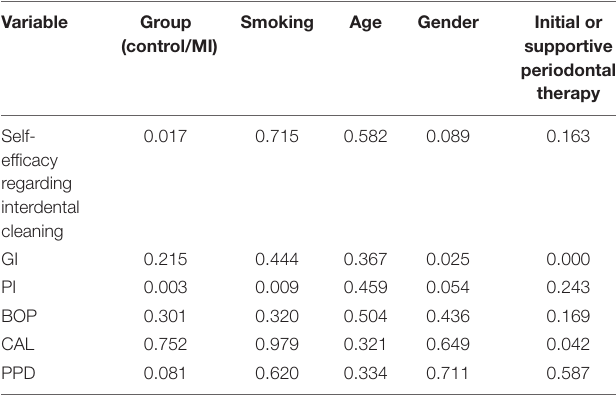
TABLE 4 | Regression analysis with p -values regarding different variable changes.